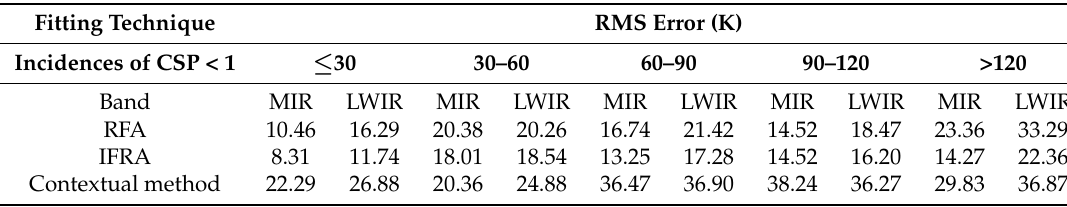
Table 4. Evaluation of robustness to outliers of each BT fitting process using root mean square error in comparision to average contamination-free BTs in MIR and